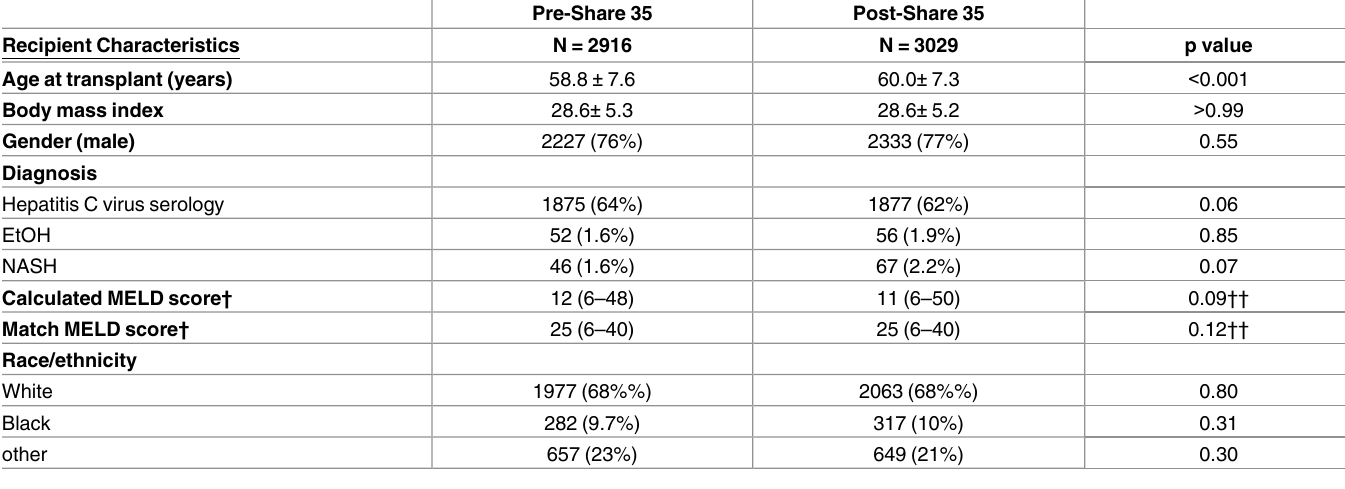
Table 2. Recipient characteristics in patients undergoing liver transplantation for hepatocellular carcinoma in Era 1 (Pre-Share 35) and Era 2 (Post-Share 35).